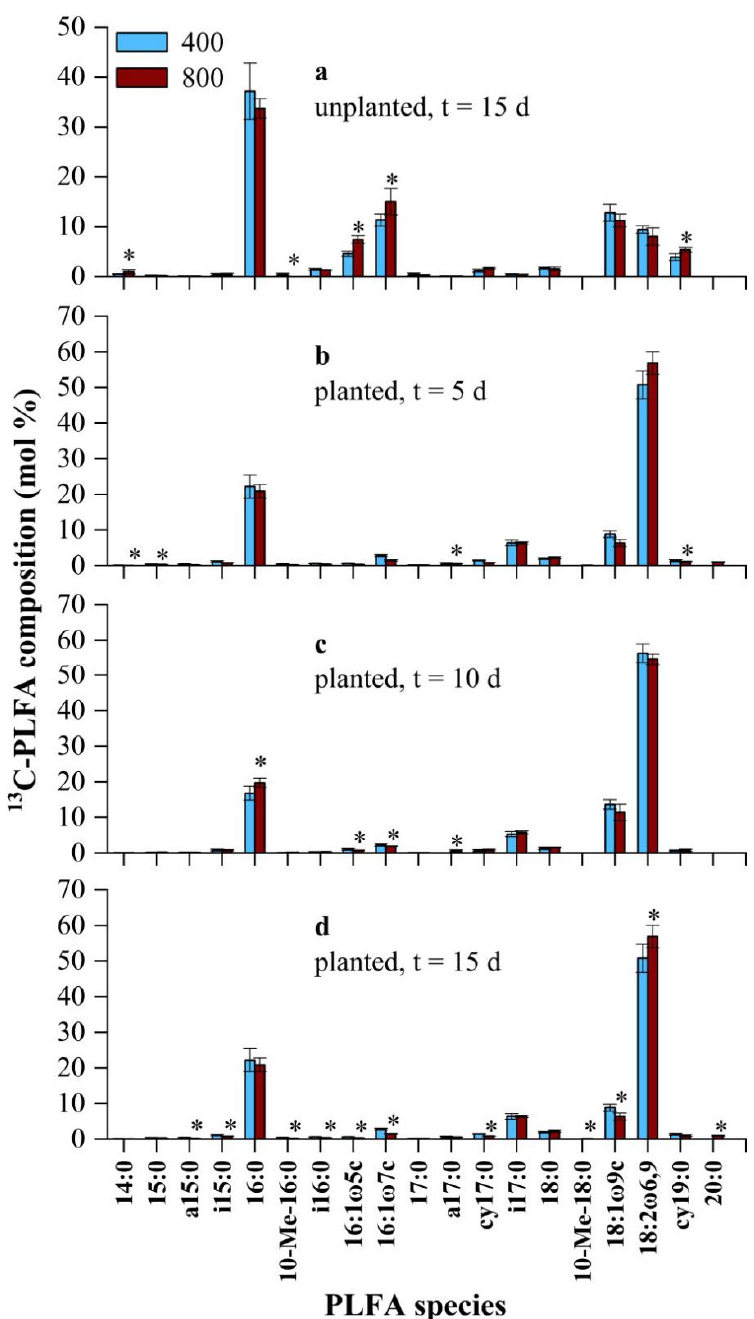
Figure 4. Differences in 13 C- PLFA composition (mol%) between the 400 and 800 µmol · mol −1 CO 2 treatment groups in unplanted ( a ) and planted ( b – d ) soils on each sampling day. Labels shown in the figure represent significant 13 C - PLFA biomarkers ( p < 0.05). 400:400 µmol mol −1 CO 2 treatment; 800:800 µmol · mol −1 CO 2 treatment. Bars represent the standard errors of the means ( n = 4). *: p < 0.05.